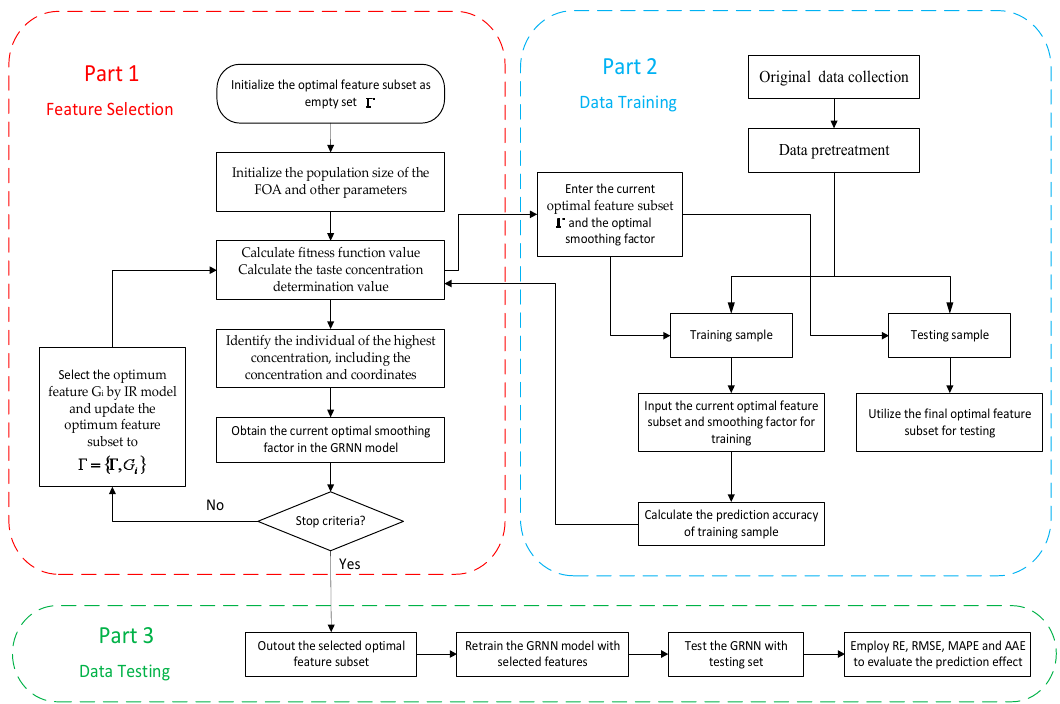
Figure 3. The flow chart of FOA-IR-GRNN. FOA: fruit fly optimization algorithm; IR: inconsistency rate; RE: relative error; RMSE: root mean square error; MAPE: mean absolute percentage error; AAE: average absolute error.